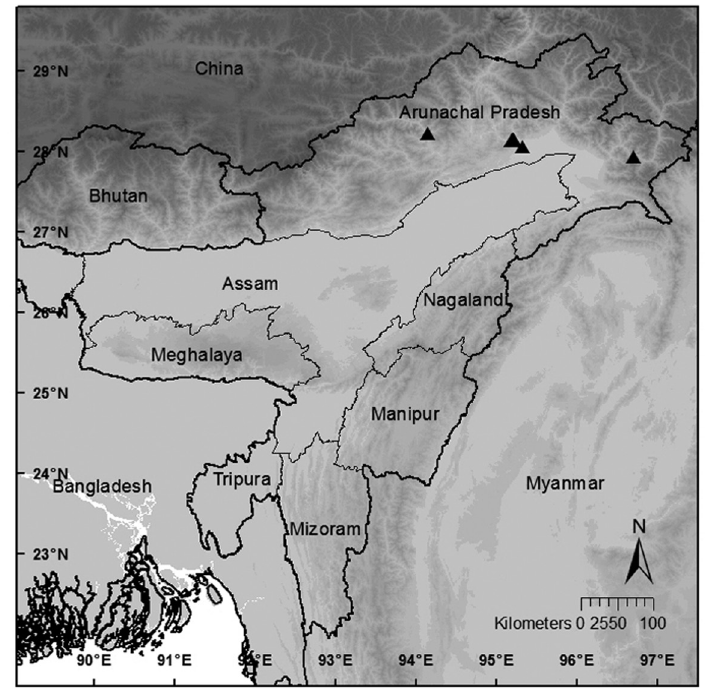
Fig. 30. Map showing the location of B. iridescens Dunn